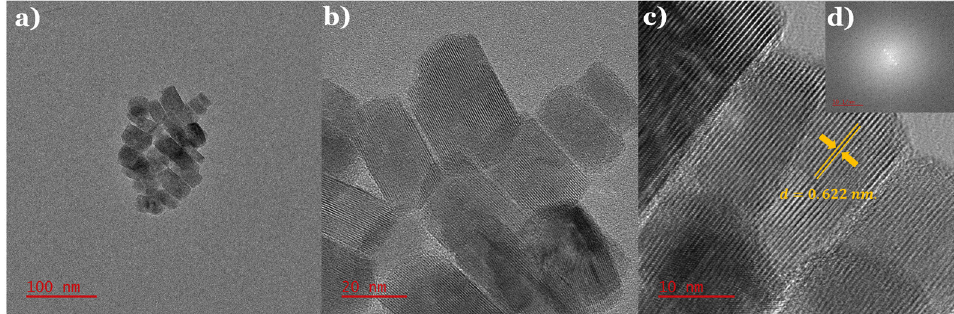
Figure 5. ( a – c ) show TEM and HRTEM images of CuCrS 2 nanosheets with d -spacing and inset corresponds to its FFT. ( d ) corresponds to its